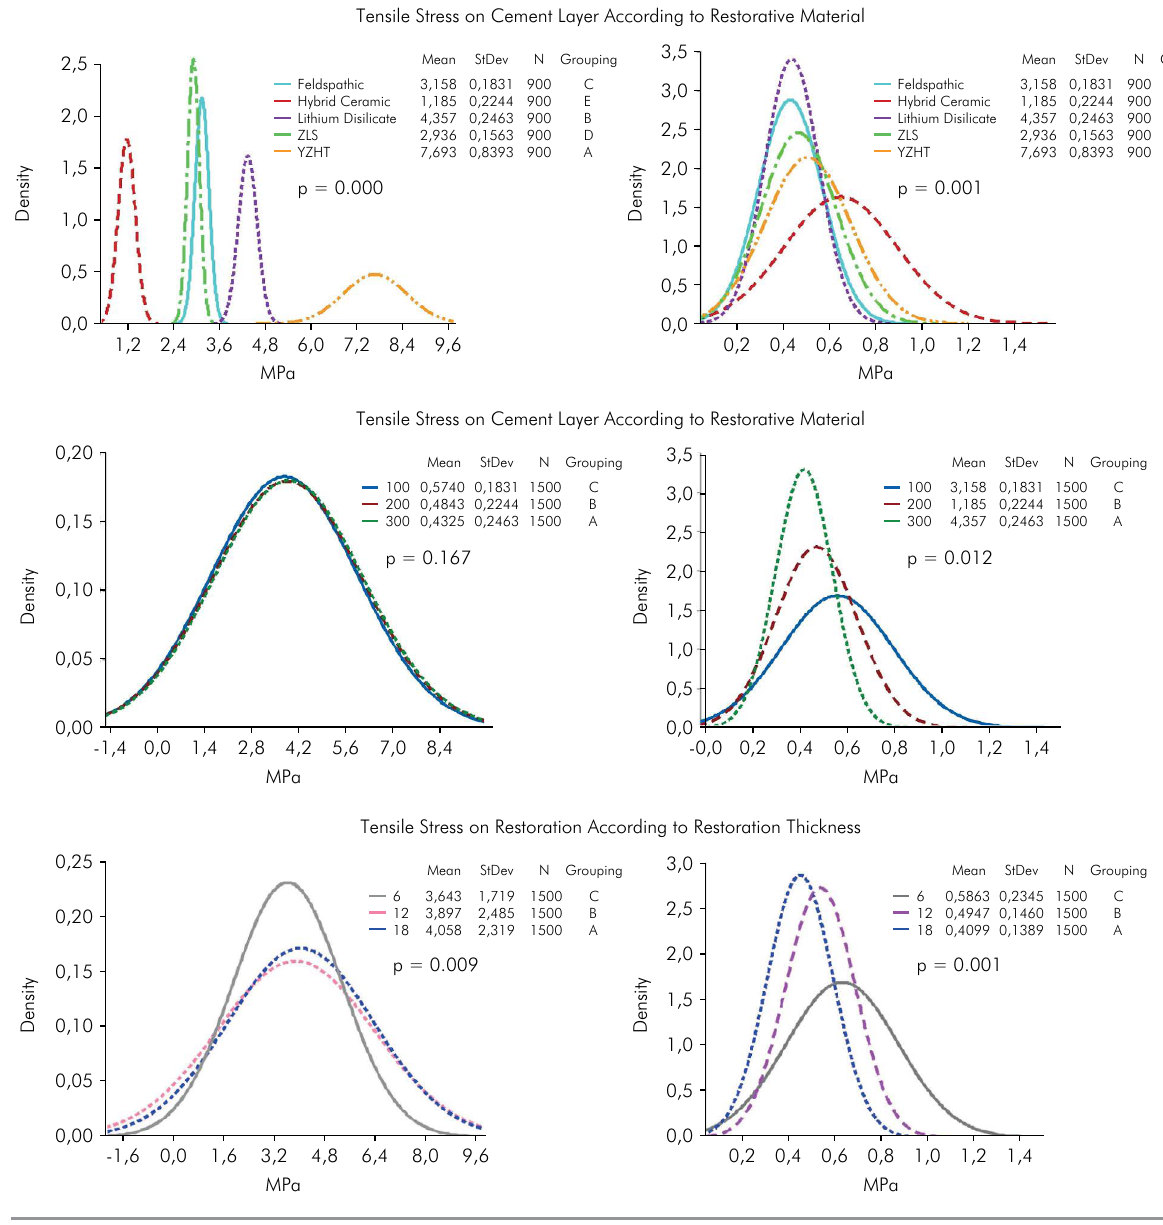
Figure 4. Histograms of tensile stress peaks at the adhesive interface. On the left, results obtained on the internal face of the restoration. On the right, results obtained in the cement layer. Factors from top to bottom are material, cement thickness, and restoration thickness. The graphs show descriptive statistics (means and standard deviations), and one-way ANOVA and Tukey’s tests results ( α